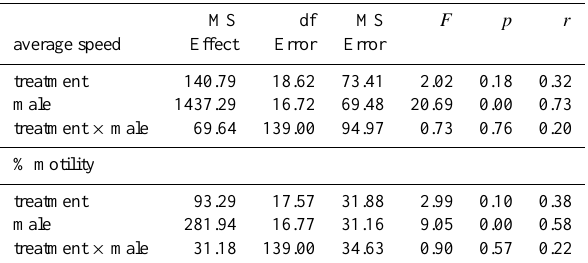
Table 3. ANOVA results of effect of CO 2 “treatment” (fixed) and male (random) on sperm swimming speed and % motility along with the interaction of treatment ×